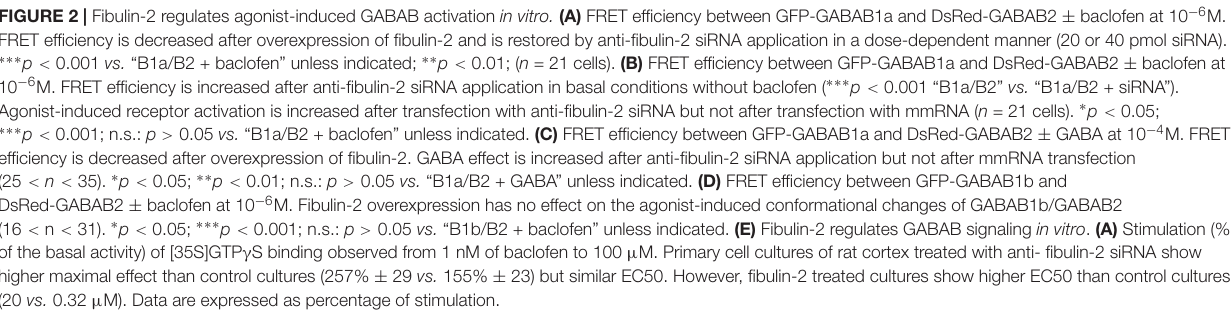
FIGURE 2 | Fibulin-2 regulates agonist-induced GABAB activation in vitro. (A) FRET efficiency between GFP-GABAB1a and DsRed-GABAB2 ± baclofen at 10 − 6 M. FRET efficiency is decreased after overexpression of fibulin-2 and is restored by anti-fibulin-2 siRNA application in a dose-dependent manner (20 or 40 pmol siRNA). ∗∗∗ p < 0.001 vs. “B1a/B2 + baclofen” unless indicated; ∗∗ p < 0.01; ( n = 21 cells). (B) FRET efficiency between GFP-GABAB1a and DsRed-GABAB2 ± baclofen at 10 − 6 M. FRET efficiency is increased after anti-fibulin-2 siRNA application in basal conditions without baclofen ( ∗∗∗ p < 0.001 “B1a/B2” vs. “B1a/B2 + siRNA”). Agonist-induced receptor activation is increased after transfection with anti-fibulin-2 siRNA but not after transfection with mmRNA ( n = 21 cells). ∗ p < 0.05; ∗∗∗ p < 0.001; n.s.: p > 0.05 vs. “B1a/B2 + baclofen” unless indicated. (C) FRET efficiency between GFP-GABAB1a and DsRed-GABAB2 ± GABA at 10 − 4 M. FRET efficiency is decreased after overexpression of fibulin-2. GABA effect is increased after anti-fibulin-2 siRNA application but not after mmRNA transfection (25 < n < 35). ∗ p < 0.05; ∗∗ p < 0.01; n.s.: p > 0.05 vs. “B1a/B2 + GABA” unless indicated. (D) FRET efficiency between GFP-GABAB1b and DsRed-GABAB2 ± baclofen at 10 − 6 M. Fibulin-2 overexpression has no effect on the agonist-induced conformational changes of GABAB1b/GABAB2 (16 < n < 31). ∗ p < 0.05; ∗∗∗ p < 0.001; n.s.: p > 0.05 vs. “B1b/B2 + baclofen” unless indicated. (E) Fibulin-2 regulates GABAB signaling in vitro . (A) Stimulation (% of the basal activity) of [35S]GTP γ S binding observed from 1 nM of baclofen to 100 µ M. Primary cell cultures of rat cortex treated with anti- fibulin-2 siRNA show higher maximal effect than control cultures (257% ± 29 vs. 155% ± 23) but similar EC50. However, fibulin-2 treated cultures show higher EC50 than control cultures (20 vs. 0.32 µ M). Data are expressed as percentage of